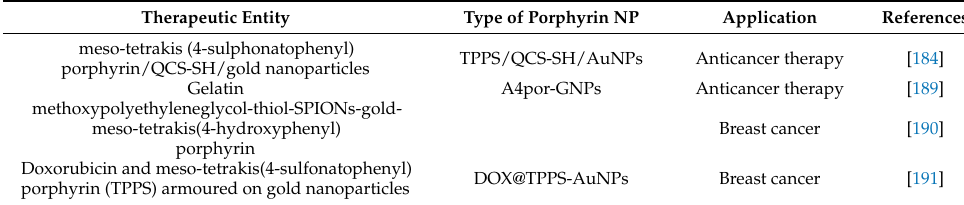
Table 14. Types of porphyrin NPs with their applications in cancer therapy.